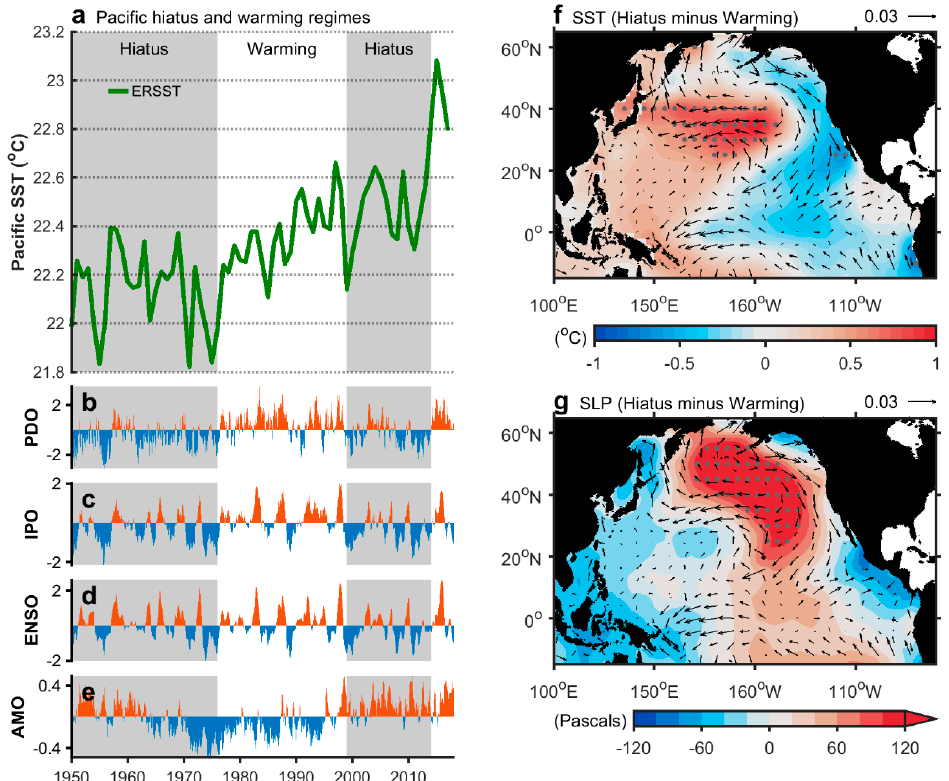
Figure 2. The Pacific hiatus and warming regimes. ( a ) The Pacific hiatus and warming regimes. Time series of the sea surface temperature (SST) over the Pacific (100°E–70°W, 20°S–65°N, domain in Figure 2f) from the Extended Reconstructed Sea Surface Temperature (ERSST) are shown. The periods of 1st and 2nd gray shadings are before 1976 and during 1999–2013, respectively; ( b – e ) Time series of the Pacific Decadal Oscillation (PDO), Inter-decadal Pacific Oscillation (IPO), El Niño-Southern Oscillation (ENSO), and Atlantic Multi-decadal Oscillation (AMO) are shown; ( f ) The differences in the SST (shading) and wind stress (vector) are shown, obtained by variables during the 1999–2013 hiatus period minus those during the 1976–1998 warming period; ( g ) Same as ( f ), but the shading is sea level pressure (SLP) difference; ( f , g ) Data are from ERSST and NCEPr1. Gray dots indicate statistical significance above the 90% confidence level. The units of vector in ( f , g ) are N m − 2 .